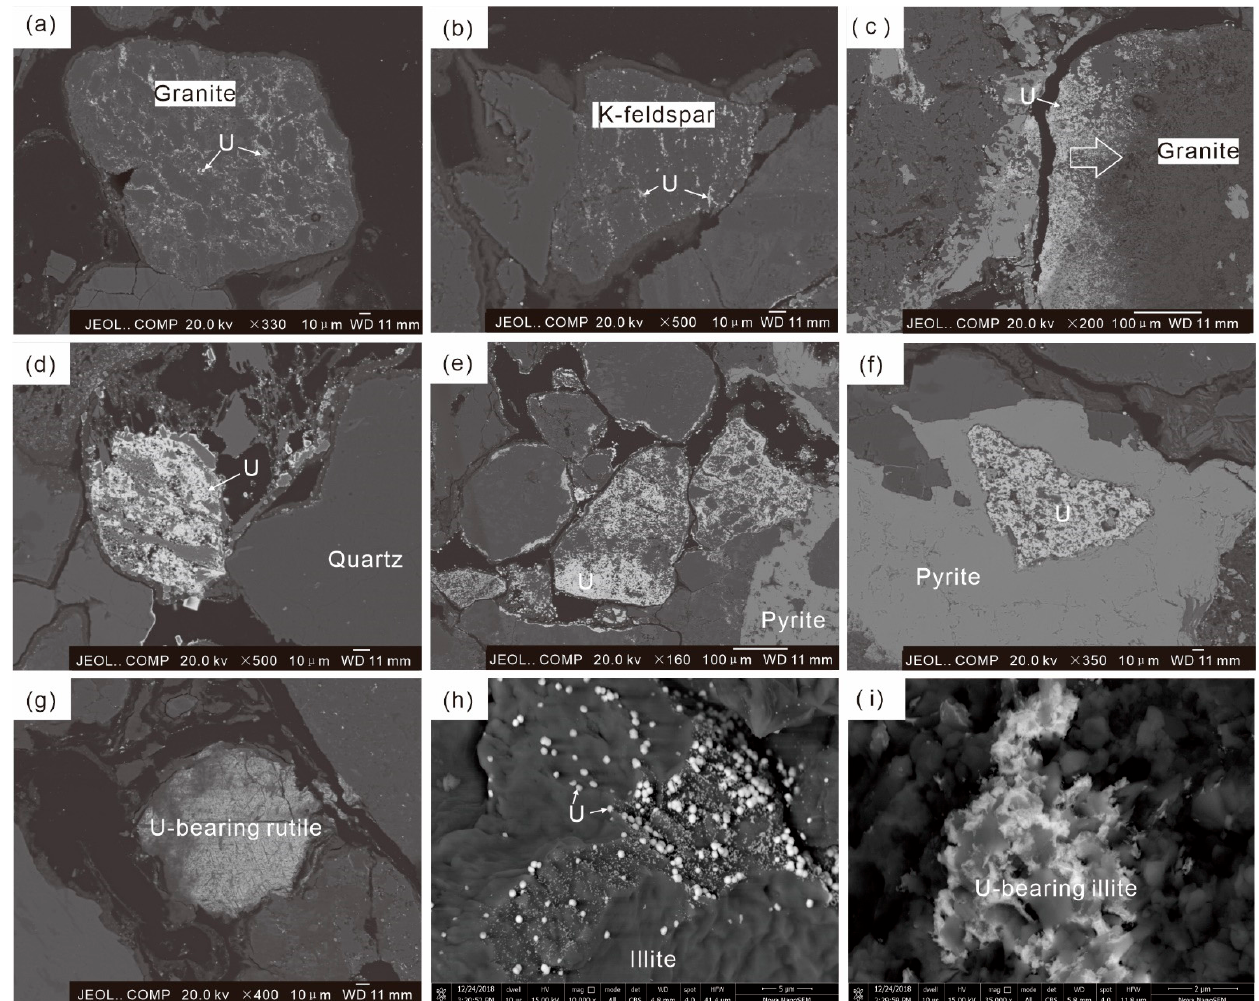
Figure 4. The SEM images of uranium minerals in the Kamust uranium deposit. ( a ) Granite fragment dissolved and filled by pitchblende. ( b ) Potassium feldspar dissolved and filled by pitchblende. ( c ) Pitchblende filling the dissolved pores along the edge of granite fragment, indicating the process of uranium minerals replacing granite. ( d , e ) Pitchblende almost completely replacing granite fragments. ( f ) Granite fragments replaced by pitchblende are wrapped by pyrite, indicating that the pyrite is formed after uranium minerals. ( g ) Pitchblende replacing rutile with a residually recognizable crystal structure. ( h ) Spherical coffinite attached to the surface of illite. ( i ) Uranium-bearing illite, showing adsorption of uranium on the illite.